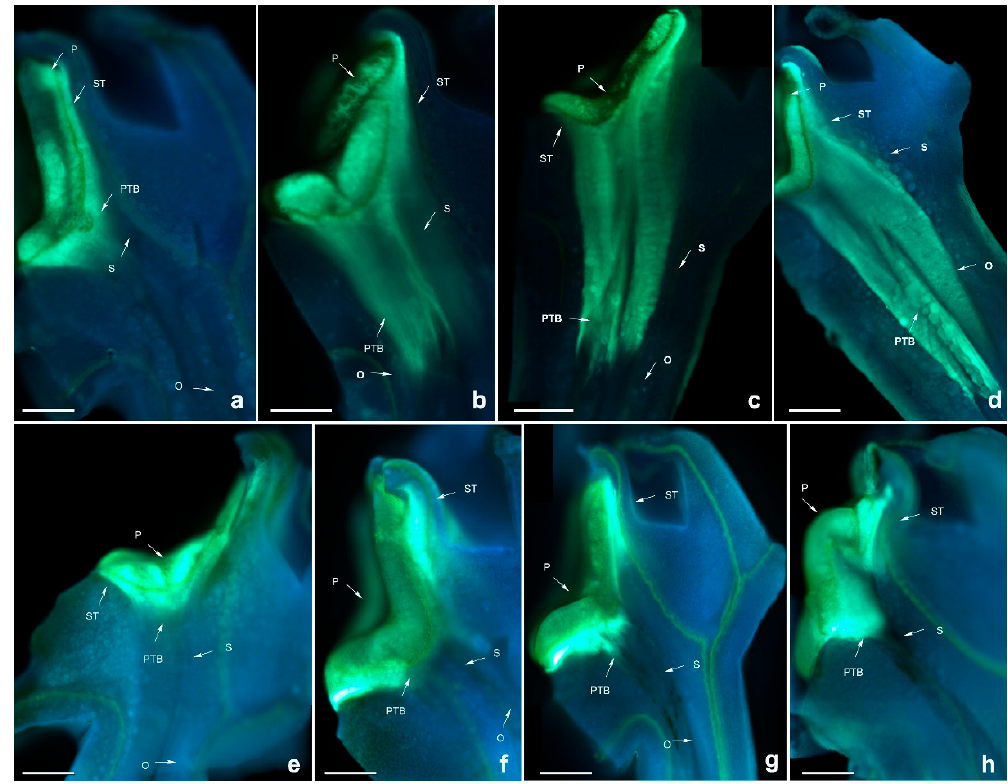
Figure 6. Growth of pollen tubes after self- and cross-pollination of Dendrobium densiflorum . P: pollinium; ST: stigma; PTB: pollen tube bundle; S: style; O: ovary. ( a ) 24 h after cross-pollination; ( b ) 48 h after cross-pollination; ( c ) 72 h after cross-pollination; ( d ) 96 h after cross-pollination; ( e ) 24 h after self-pollination; ( f ) 48 h after self-pollination; ( g ) 72 h after self-pollination; ( h ) 96 h after self-pollination. Bars = 100 µm.